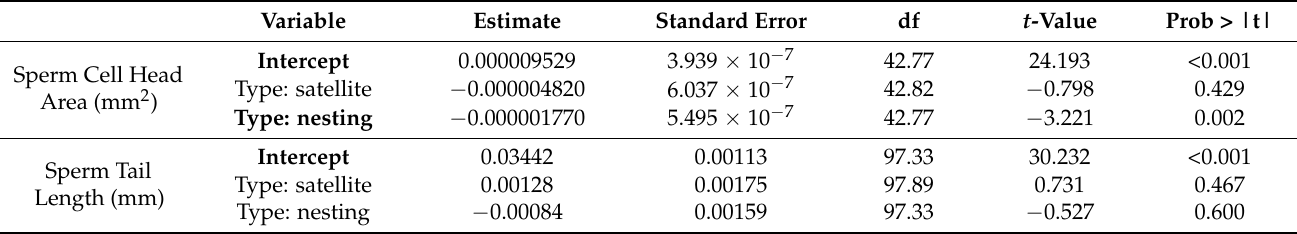
Figure 4. Sperm cell heads ( A ) were significantly larger for sneaker males than either satellite or nesting males. No differences in sperm tail length ( B ) among male types were found. On the x-axis: SN = sneaker males, SAT = satellite males, NM = nesting males. Lower case letters represent the male types that are significantly different from one another. See Table 2 and the text for full details and statistical results. Table 2. Results of the best fit mixed effect models comparing sperm cell head area and tail length among alternative male types with the sneaker male type as the baseline. Variables and interactions with significant effects are in